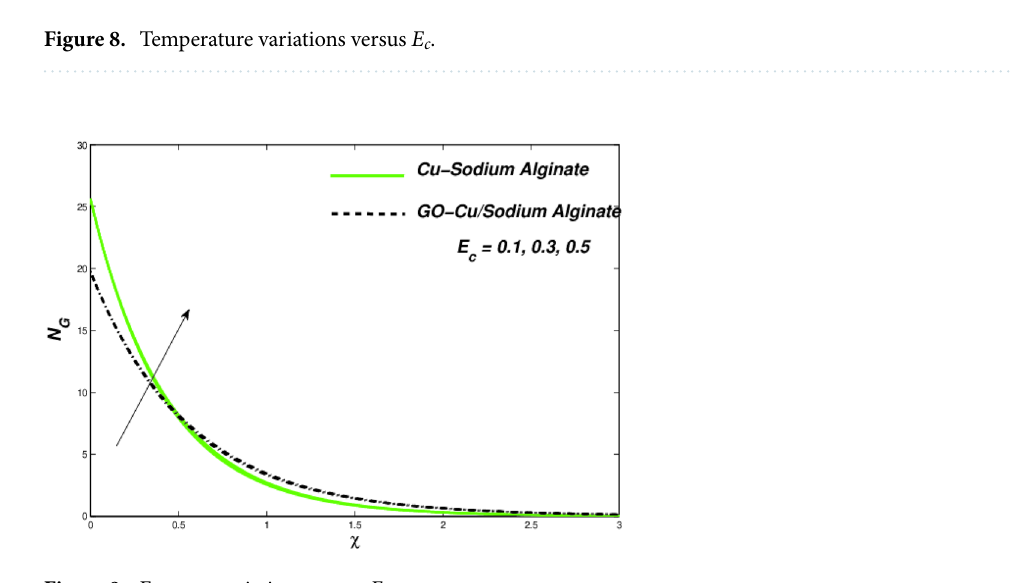
Figure 9. Entropy variations versus E c